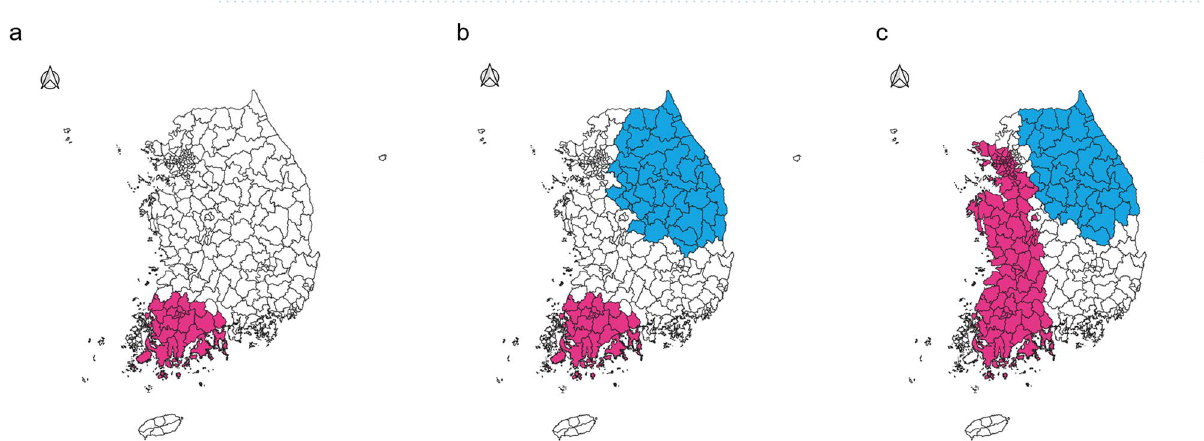
Figure 2. Spatial cluster for thyroid cancer incidence rates in Korea during ( a ) 1999–2003, ( b ) 2004–2008, and ( c ) 2009–2013. Red colored area in the southwest region and the blue colored area in the northeast region indicate spatial clusters with high and low thyroid cancer incidence rates,